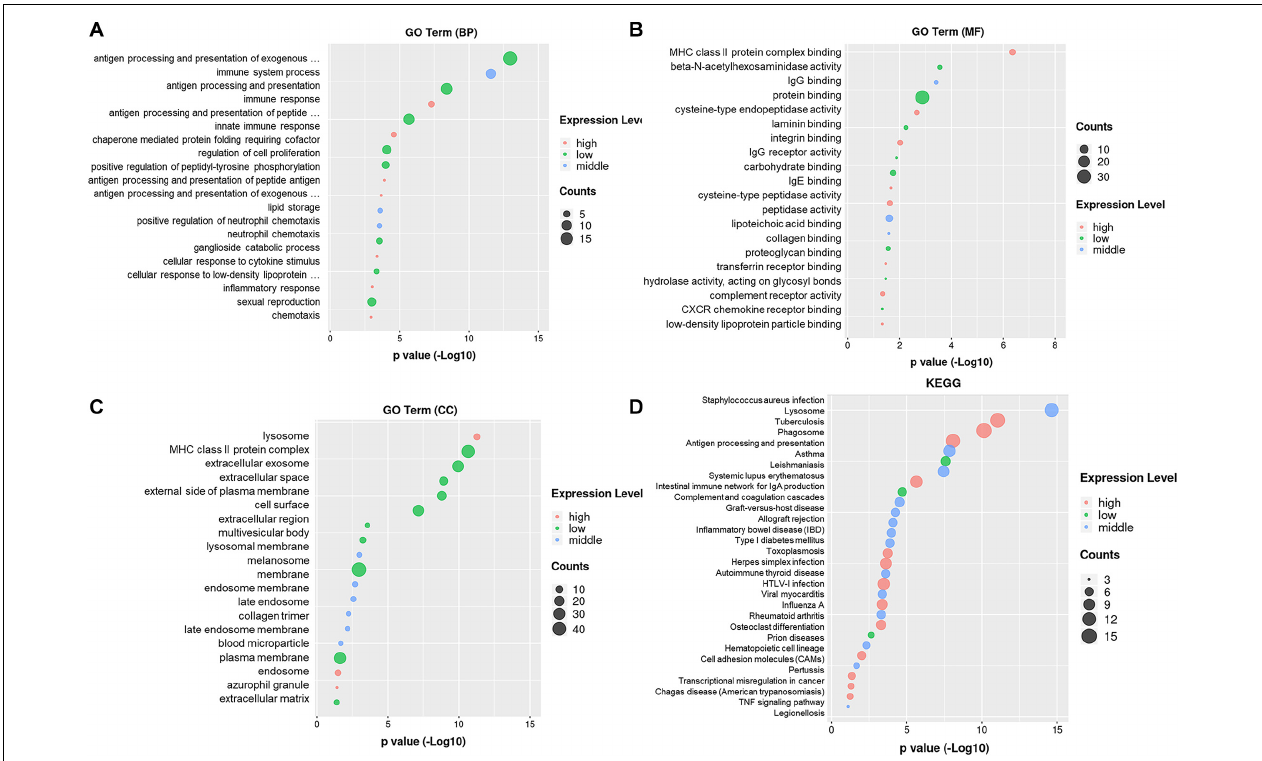
FIGURE 2 | Gene ontology enrichment and KEGG analysis on DEmRNAs. (A) Gene ontology enrichment analysis on genes relative with the biological process. (B) Gene ontology enrichment analysis on genes relative with the molecular function. (C) Gene ontology enrichment analysis on genes relative with the cellular component. (D) Pathway enrichment analysis (KEGG) on genes.